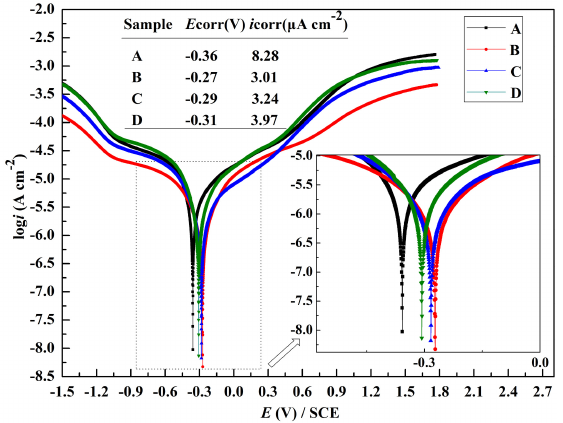
Figure 7. The potentiodynamic polarization curves for the samples immersed in the four solutions.